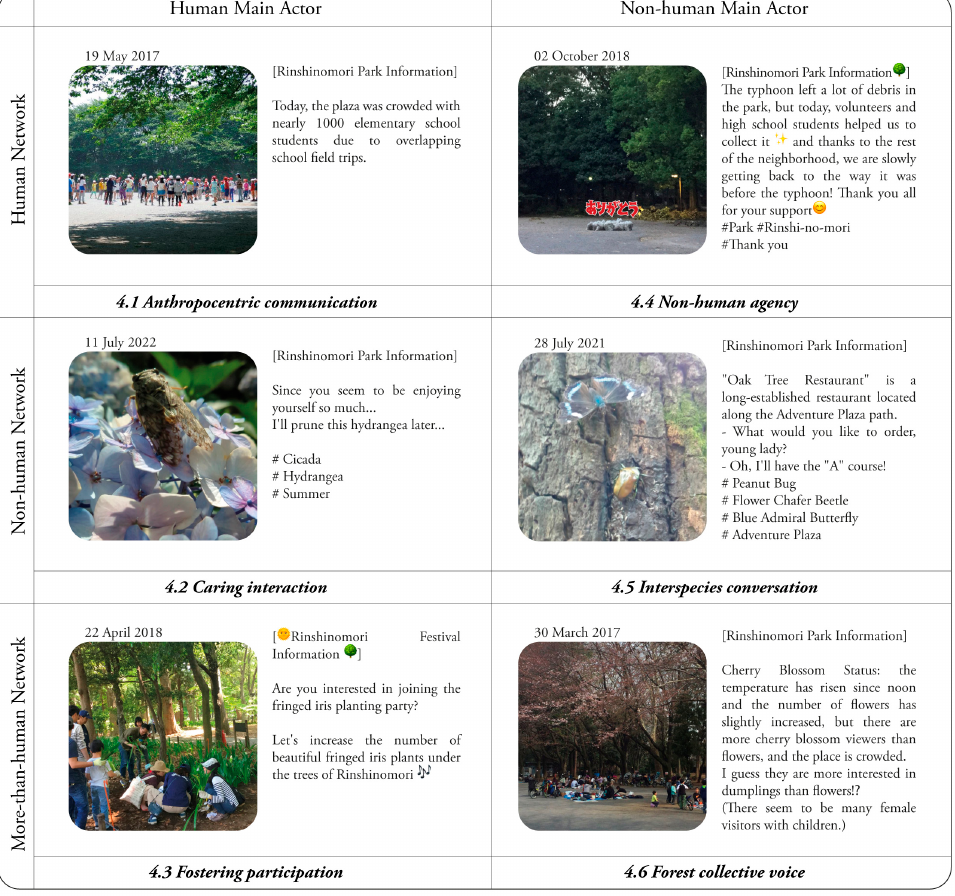
Figure 8. More-than-human communication patterns. Anthropocentric communication : relation be- tween only human actors; Caring interaction : communication from humans to non-humans; Fostering participation: a human protagonist that involves a more-than-human community; Non-human agency : the non-human actor that deploys a human network; Interspecies conversation : tweets depicting a strictly non-human conversation; Forest collective voice : an event triggered by a non-human, engenders a more-than-human actor-network.